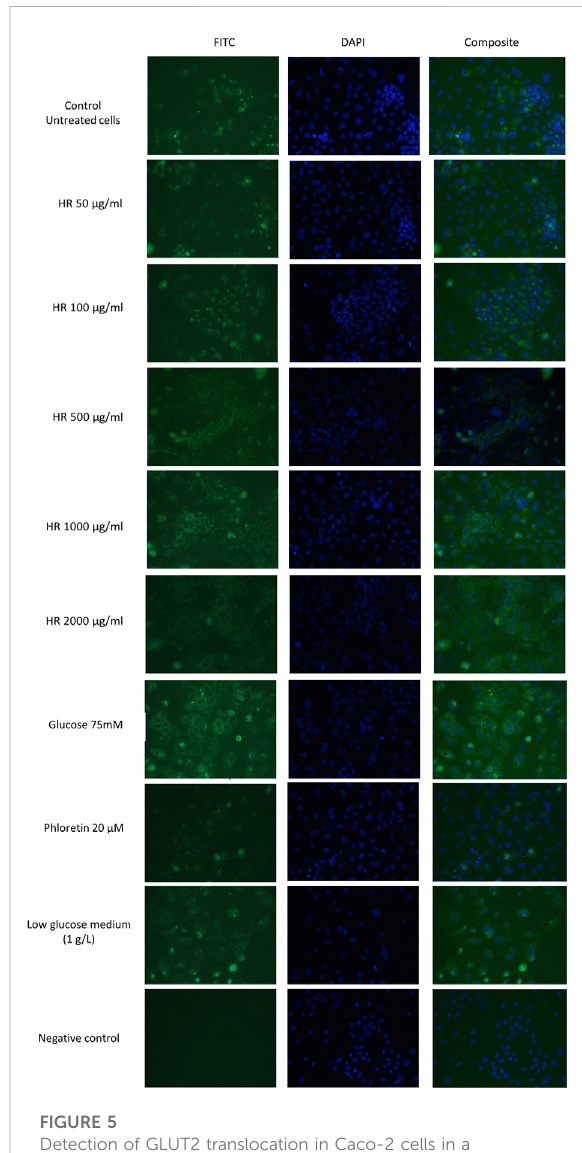
FIGURE 5 Detection of GLUT2 translocation in Caco-2 cells in a fl uorescence microscope. HR — aqueous extract from the fruit of Hipopphaë rhamnoides